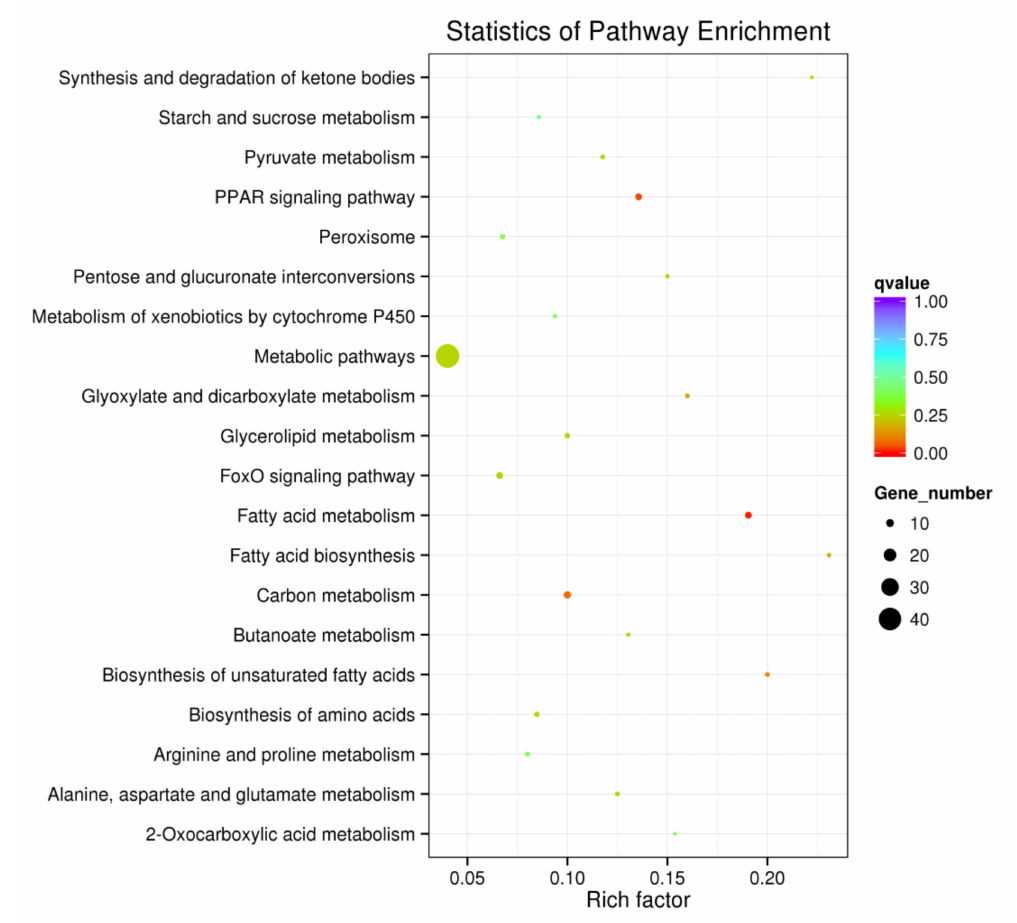
Figure 8. The pathway enrichment analyses for the